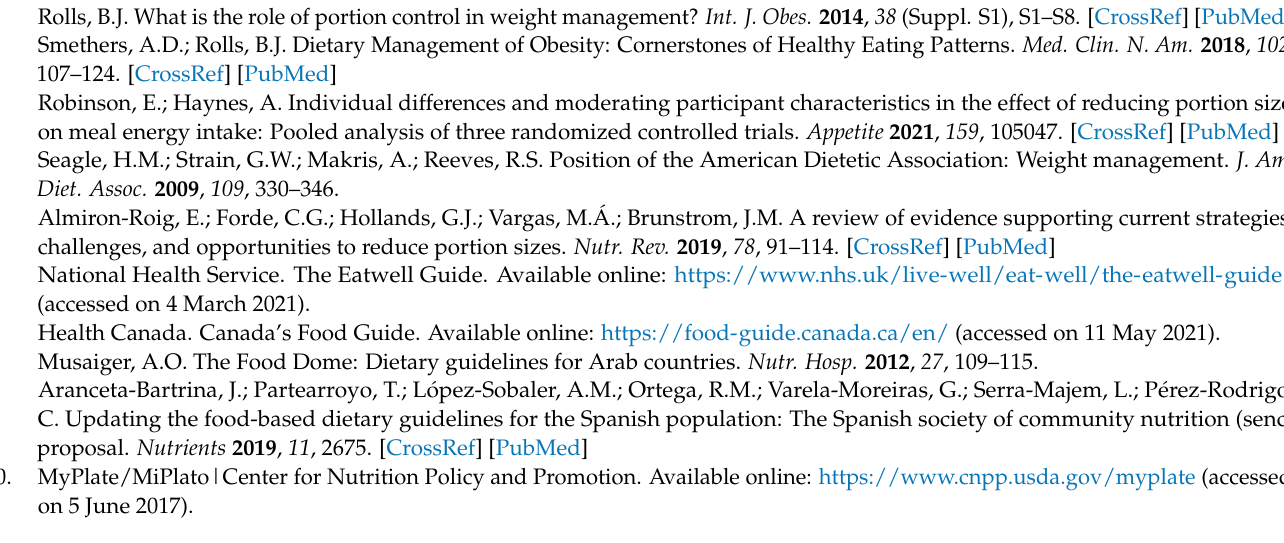
Egger’s test for funnel plot asymmetry; Figure S1: Sensitivity analysis for studies examining the impact of portion control tools on portion size choice excluding data from Fisher et al. (2013); Figure S2: Impact of portion control tools on portion size intake by study purpose awareness. Figure S3: Sensitivity analysis for studies examining the impact of portion control tools on portion size intake by purpose awareness excluding data from Wansink et al. (2006); Figure S4: Impact of portion control tools on portion size intake by strategy; Figure S5: Sensitivity analysis for studies examining the impact of portion control tools on portion size intake by strategy excluding data from Wansink et al. (2006); Figure S6: Sensitivity analysis for studies examining the impact of portion control tools on portion size intake by tool type; Figure S7: Impact of portion control tools on weight status by study duration (3 months outcome); Figure S8: Impact of portion control tools on weight status by study duration (6 months outcome); Figure S9: Funnel plots for studies exploring weight status using random-effects (left) and fixed- effects (right)